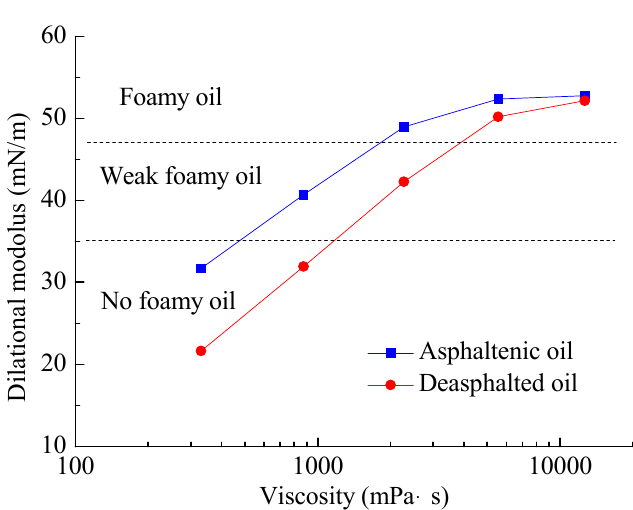
Figure 14. Viscoelastic modulus and the performance of depletion experiments of the ten oil samples.